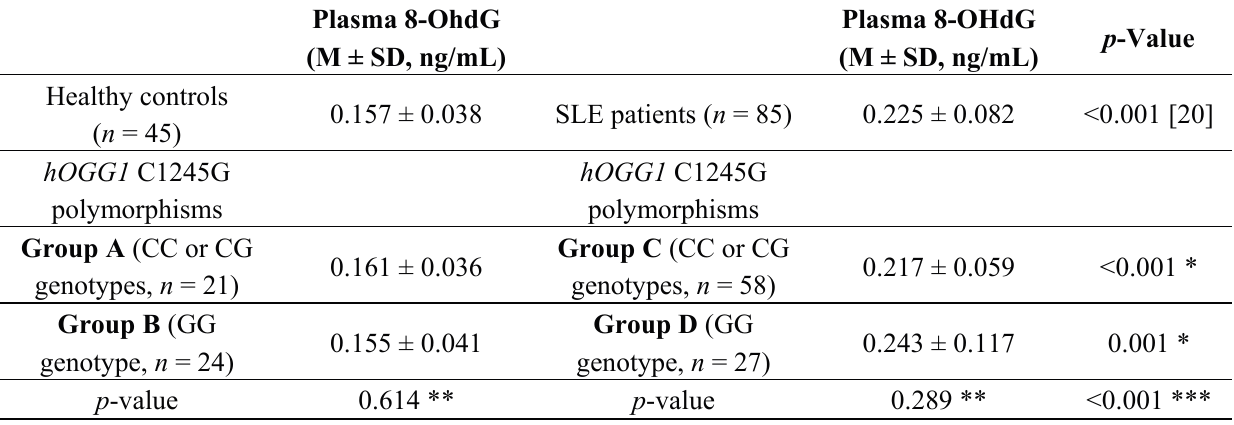
Table 2. Levels of plasma 8-hydroxy-2'-deoxyguanosine (8-OHdG) in healthy controls and SLE patients as related to the hOGG1 gene polymorphisms.